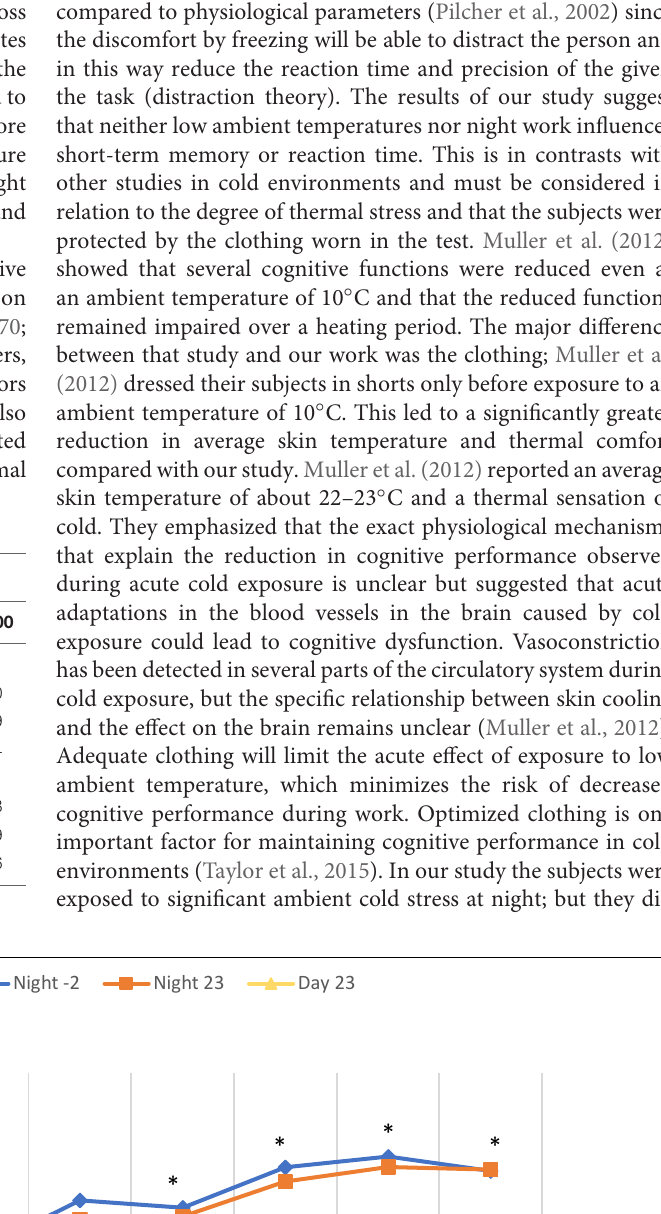
Frontiers in Physiology |